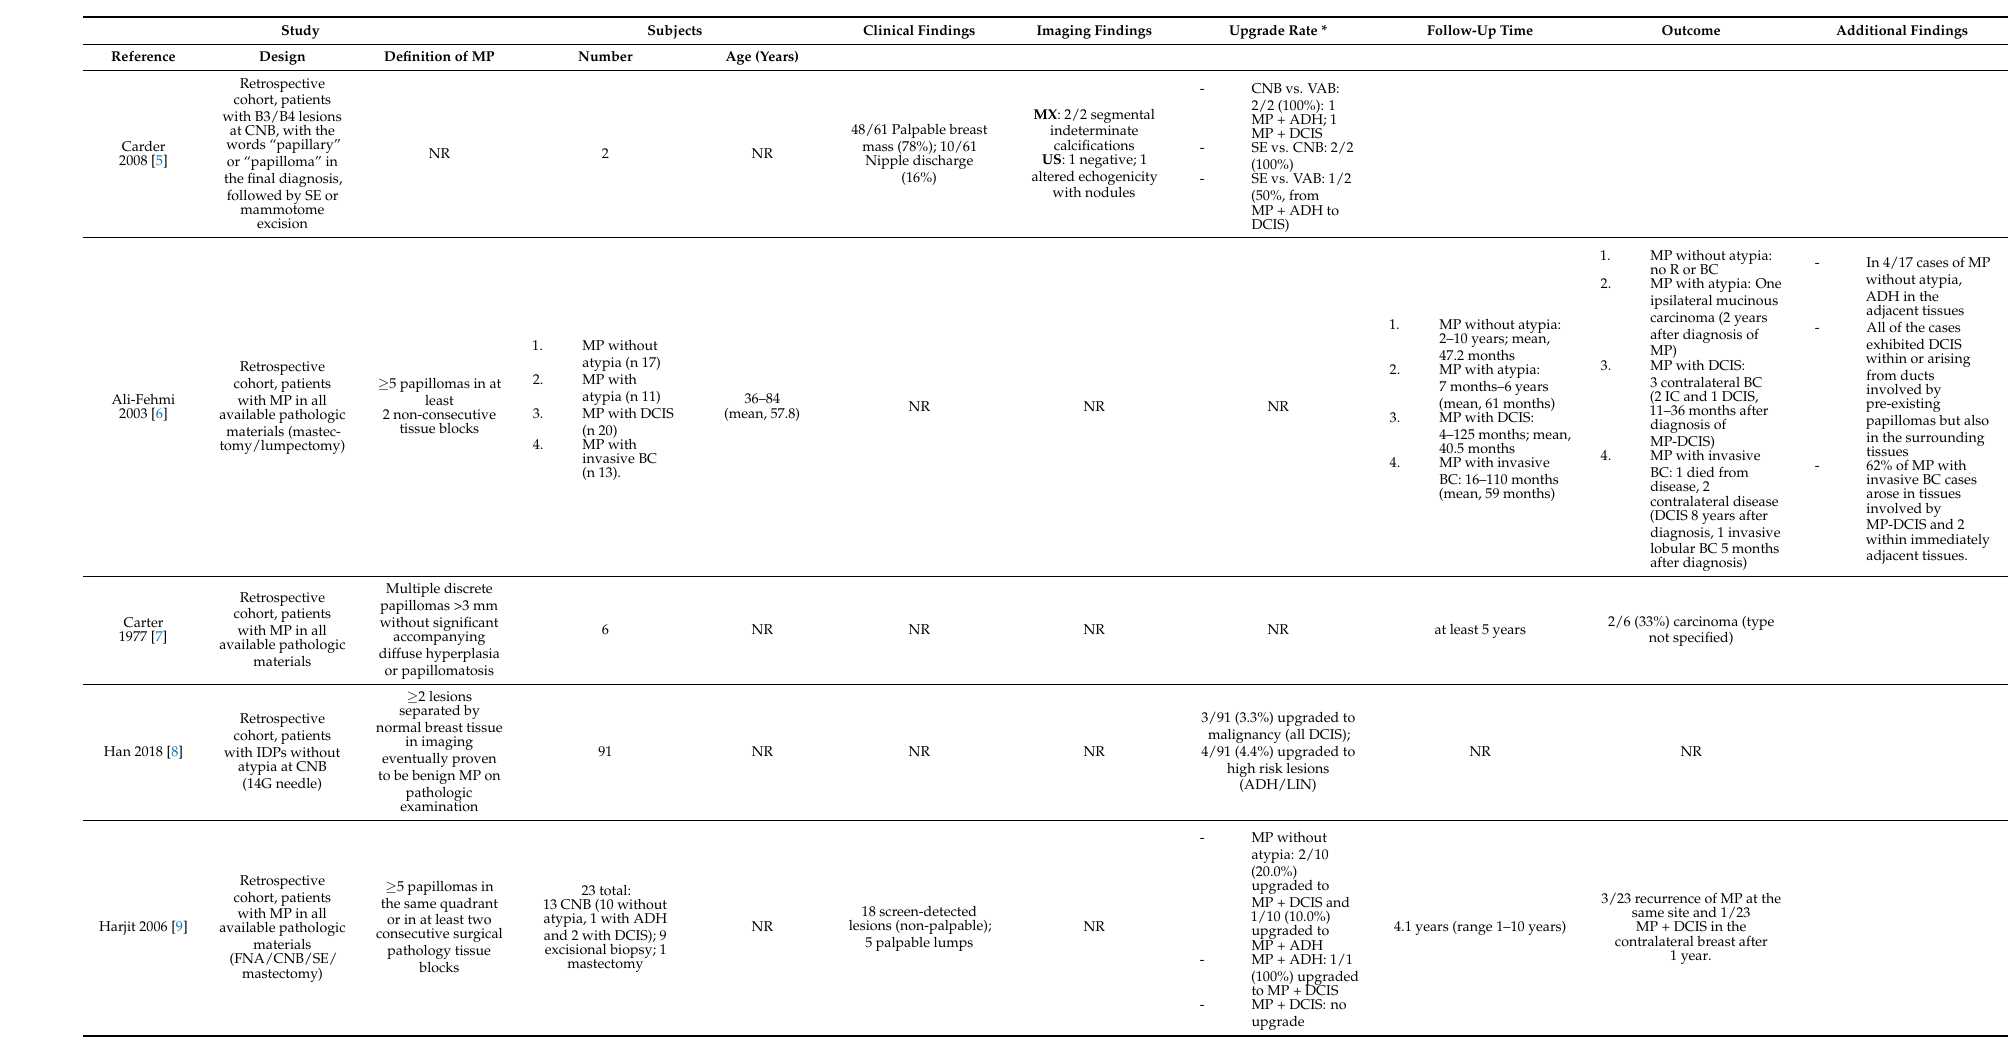
Table 1. Overview of the included